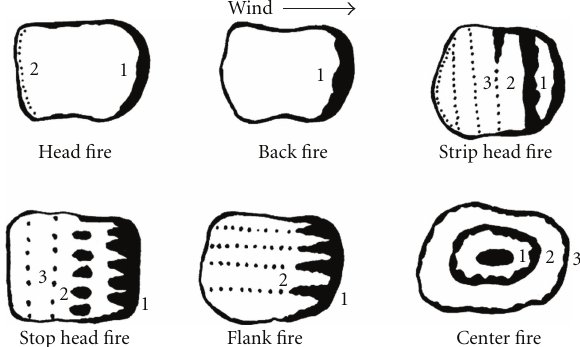
Figure 1: Prescribed fire ignition patterns designed to restrict or enhance fire front interactions [1].